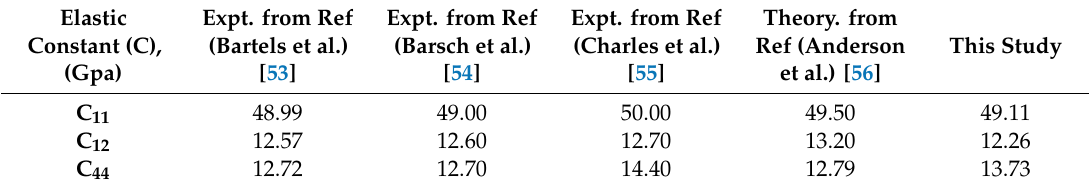
Table 1. Elastic constant values of NaCl extracted by experimental / theoretical literature and this study. Elastic